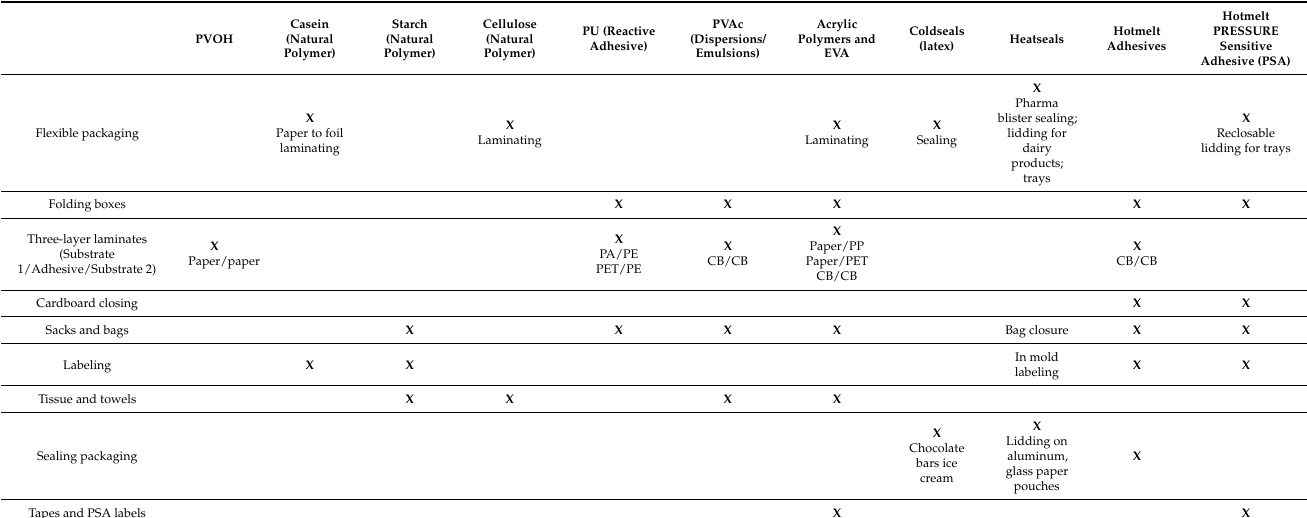
Table 11. Adhesives used in food packaging and their more common uses. Adapted from [179], and Annex I in reference [176].